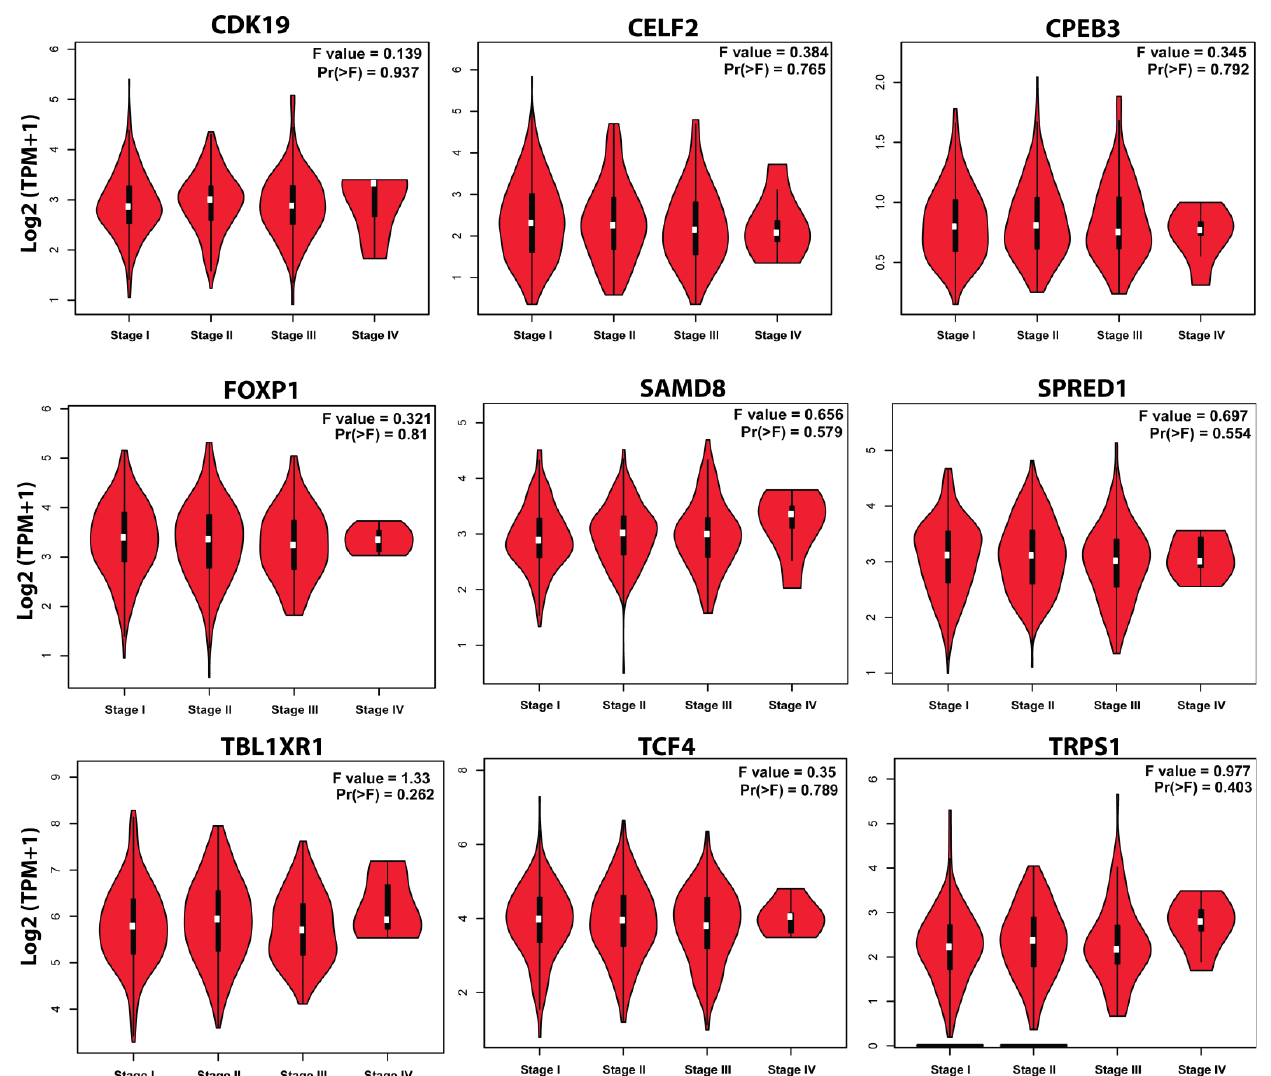
Figure 12. Pathological analysis of selected key genes CPEB3 , SAMD8 , FOXP1 , TRPS1 , TCF4 , TBL1XR1 , SPRED1 , CELF2 , and CDK19 in NSCLC. Violin plots obtained from GEPIA showing pathological stage condition for key genes using LUSC datasets in patients with NSCLC. The X ₋ axis represents the major pathological stages while the Y ₋ axis represents the log scale transformed expression data.